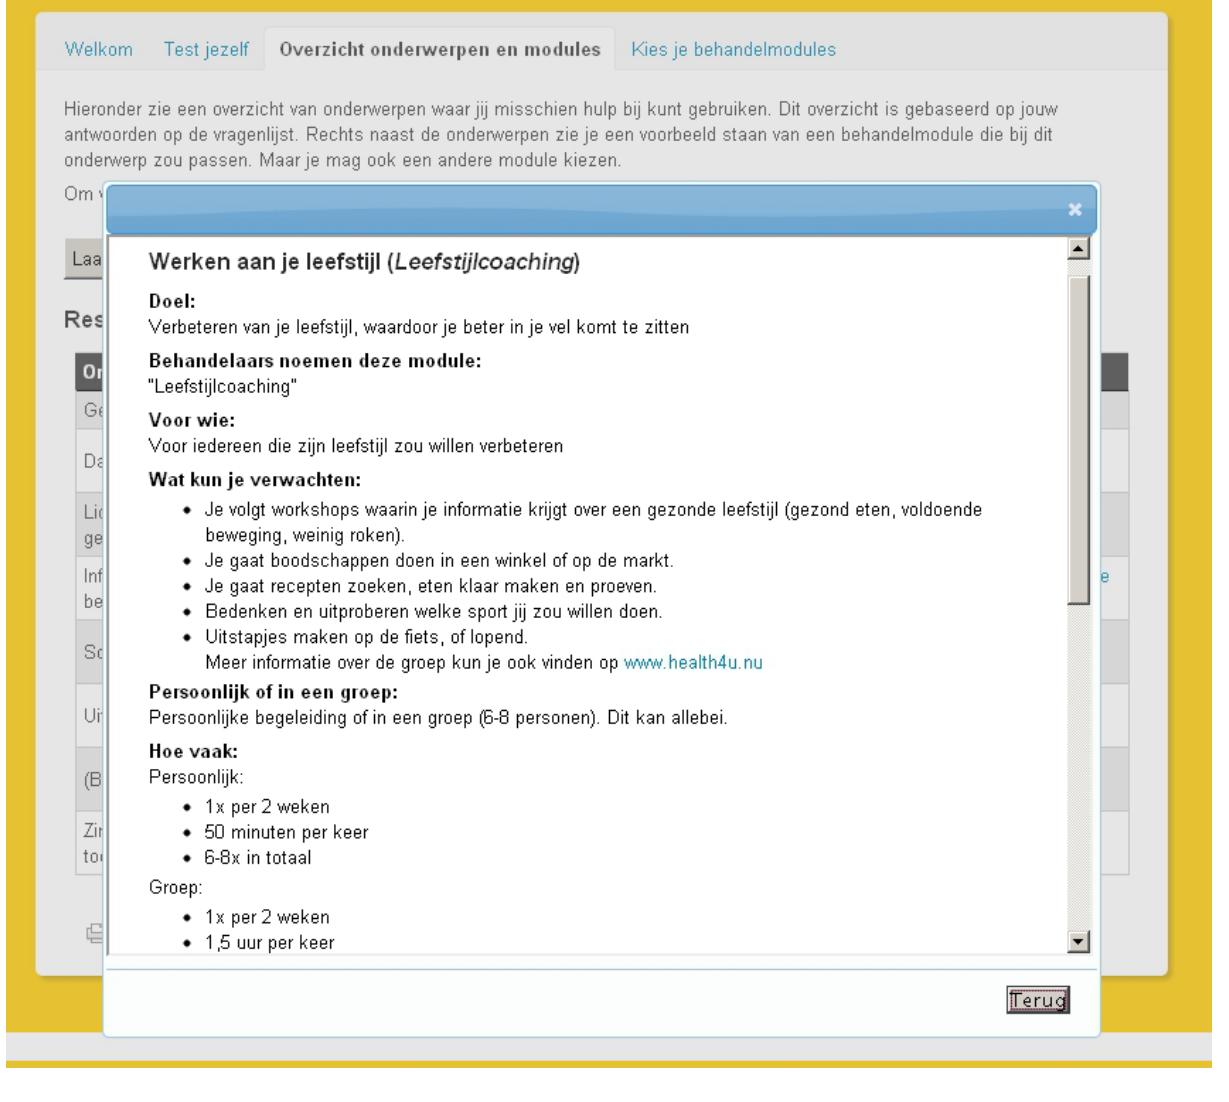
Figure 2. Screenshot of the second webpage including a digital catalog with descriptions of treatment